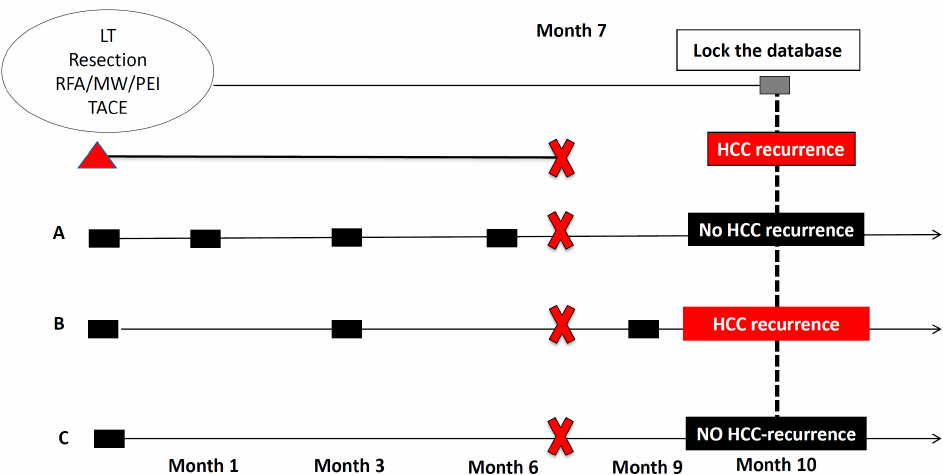
Figure 2. Impact of radiological evaluation on the rate of HCC recurrence reported. The red triangle represents the start point (the day of the treatment-LT, resection, RFA/MW/PEI or TACE-, the red cross represents the event (HCC recurrence) and the line between the two the time between treatment to HCC recurrence (7 months). The grey square represents the information inserted in the database at the day of the analysis (month 10). If this patient is evaluated in 3 different centers, which have a different radiological schedule to evaluate the radiological response, the information in the database will be different despite the patient being exactly the same. Centre A performs radiological evaluations at month 1, 3, and 6; Centre B at month-3 and 9; Centre C does not perform a defined radiological evaluation. However, all the centers have a database. Thus, if the patient develops a recurrence at month 7 and the database is locked at month-10, this patient will be considered a patient with HCC recurrence in center B because the information is in this database but no in centre A and B because the information is not in the database despite the fact that the event has already developed.